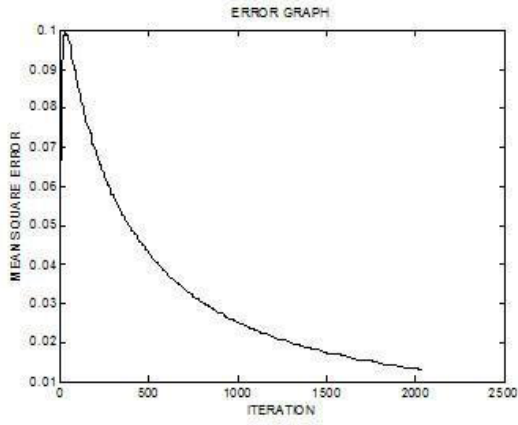
Figure 7. VIANN Root Mean Square Error